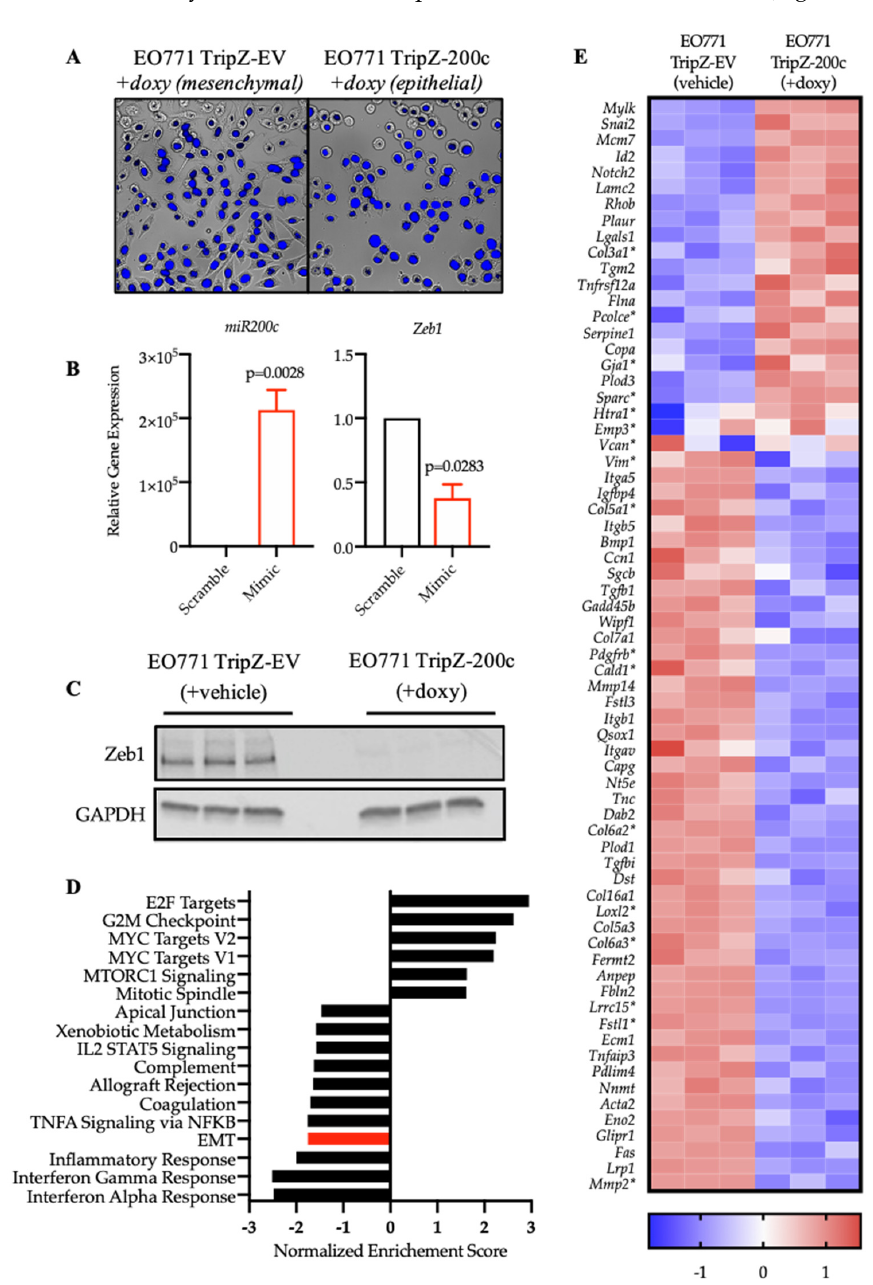
Figure 2. Restoration of miR-200c in mesenchymal-like EO771 murine mammary cancer cells restores a more epithelial phenotype. ( A ) Representative images of the change in morphology of EO771 cells in the presence of miR-200c. Cells were stained with DAPI and visualized by microscopy ( n = 2, with 10 fields of view). ( B ) Relative gene expression of miR-200c and Zeb1 by qRT-PCR anal- ysis following treatment with miR-200c mimic or scrambled oligo is shown. Data were normalized to either U6 or Gapdh and are presented as fold change relative to the scrambled oligo. ( C ) Western blot analysis revealed downregulation in Zeb1 protein levels with miR-200c restoration. GAPDH was used as a loading control. ( D ) Gene set enrichment analysis (GSEA) identified the top 15 altered “Hallmark” pathways along with their respective normalized enrichment score (NES). Epithelial to mesenchymal transition (EMT) is highlighted in red. ( E ) Heatmap of the top altered genes from the Hallmark-EMT pathway that were altered by miR-200c restoration. Each column represents an in- dividual biological replicate of EO771-TripZ-EV (Vehicle-treated, n = 3) or EO771-TripZ-miR-200c